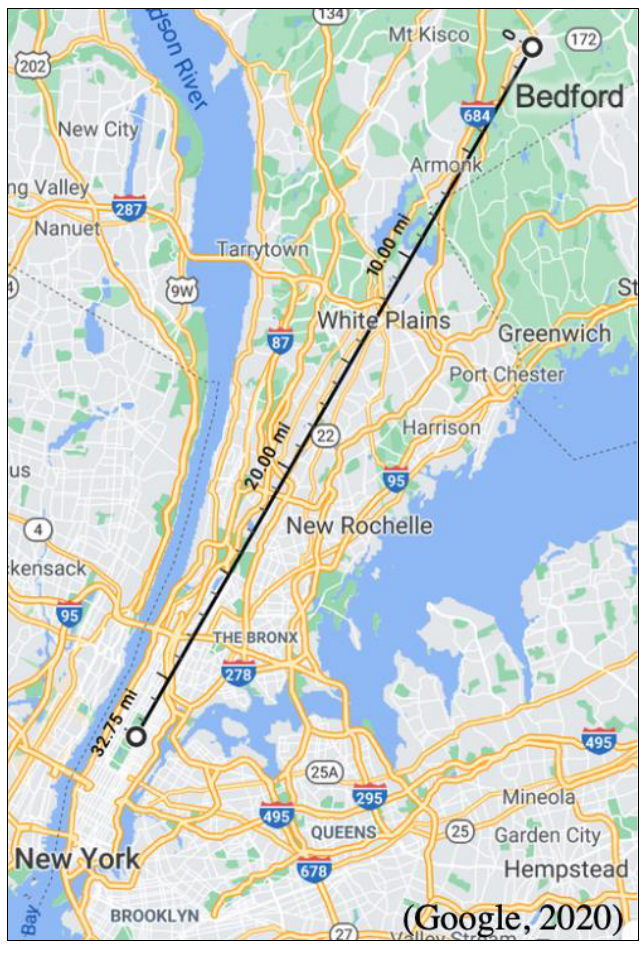
Figure 2. Google Satellite Image Depicting Bedford and its Relative Proximity to New York